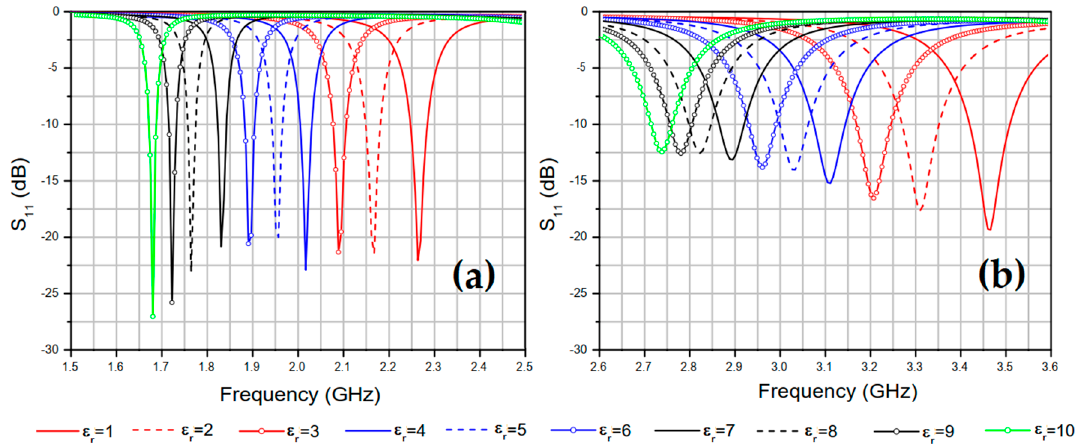
Figure 3. Reflection coefficient, S 11 (dB), results for different (MUT) relative permittivity’s values at resonant frequencies ( a ) fr 1 and ( b ) fr 2